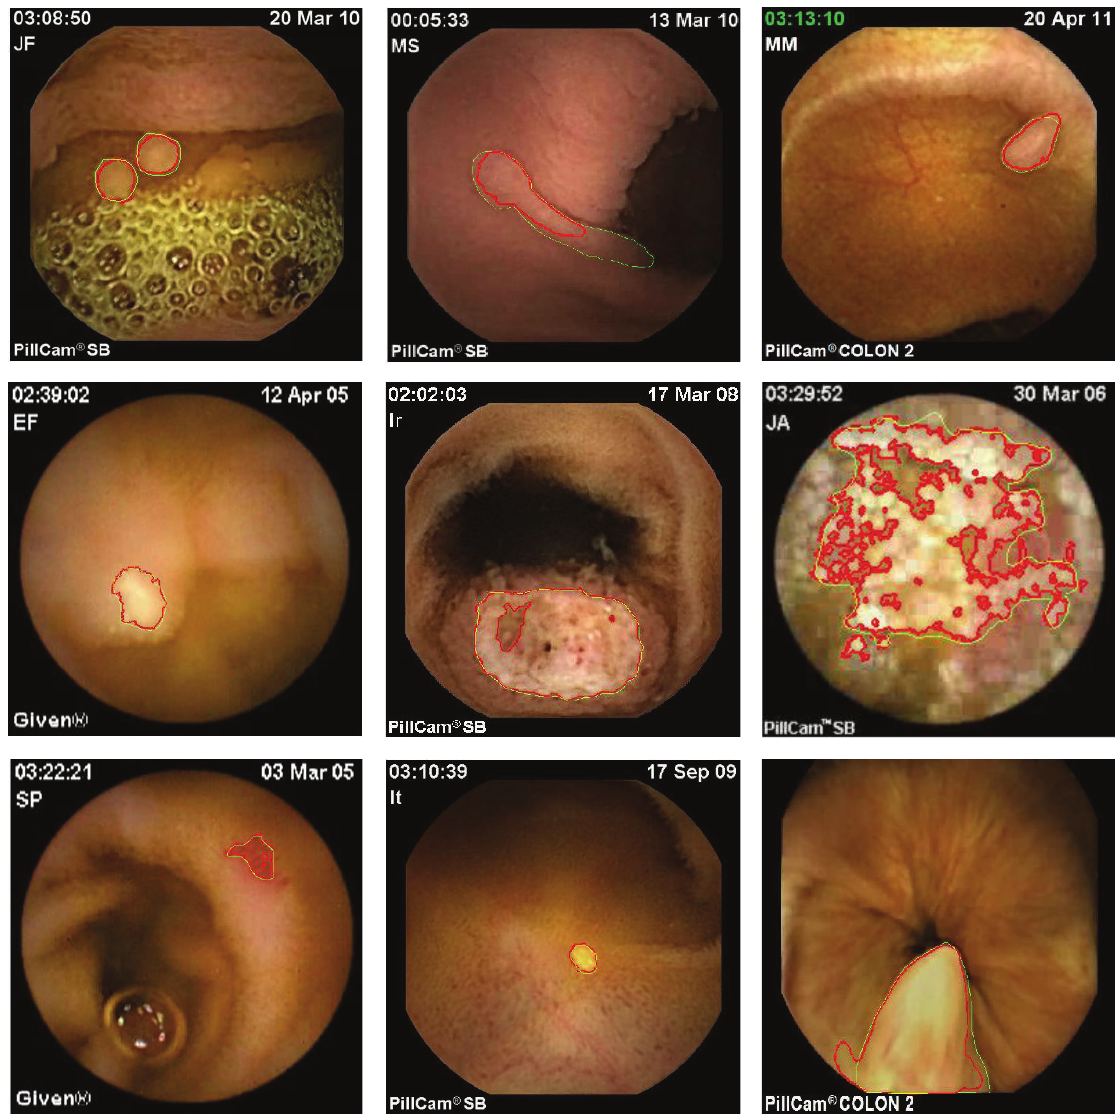
Figure 11: WCE image segmentation of Figure 8 plus, in yellow colour, the manual segmentation performed by the clinician.